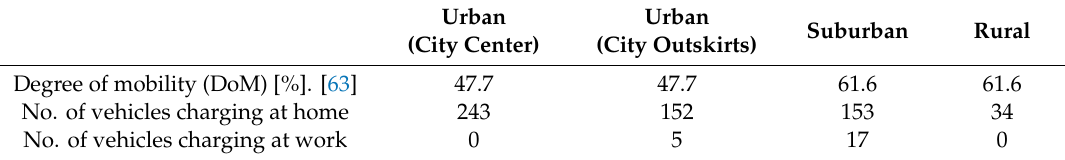
Table A1. Degree of mobility (DoM) and number of vehicles depending on the grid region. Urban Urban Suburban Rural (City Center) (City Outskirts) Degree of mobility (DoM) [%]. [63] 47.7 47.7 61.6 61.6 243 152 153